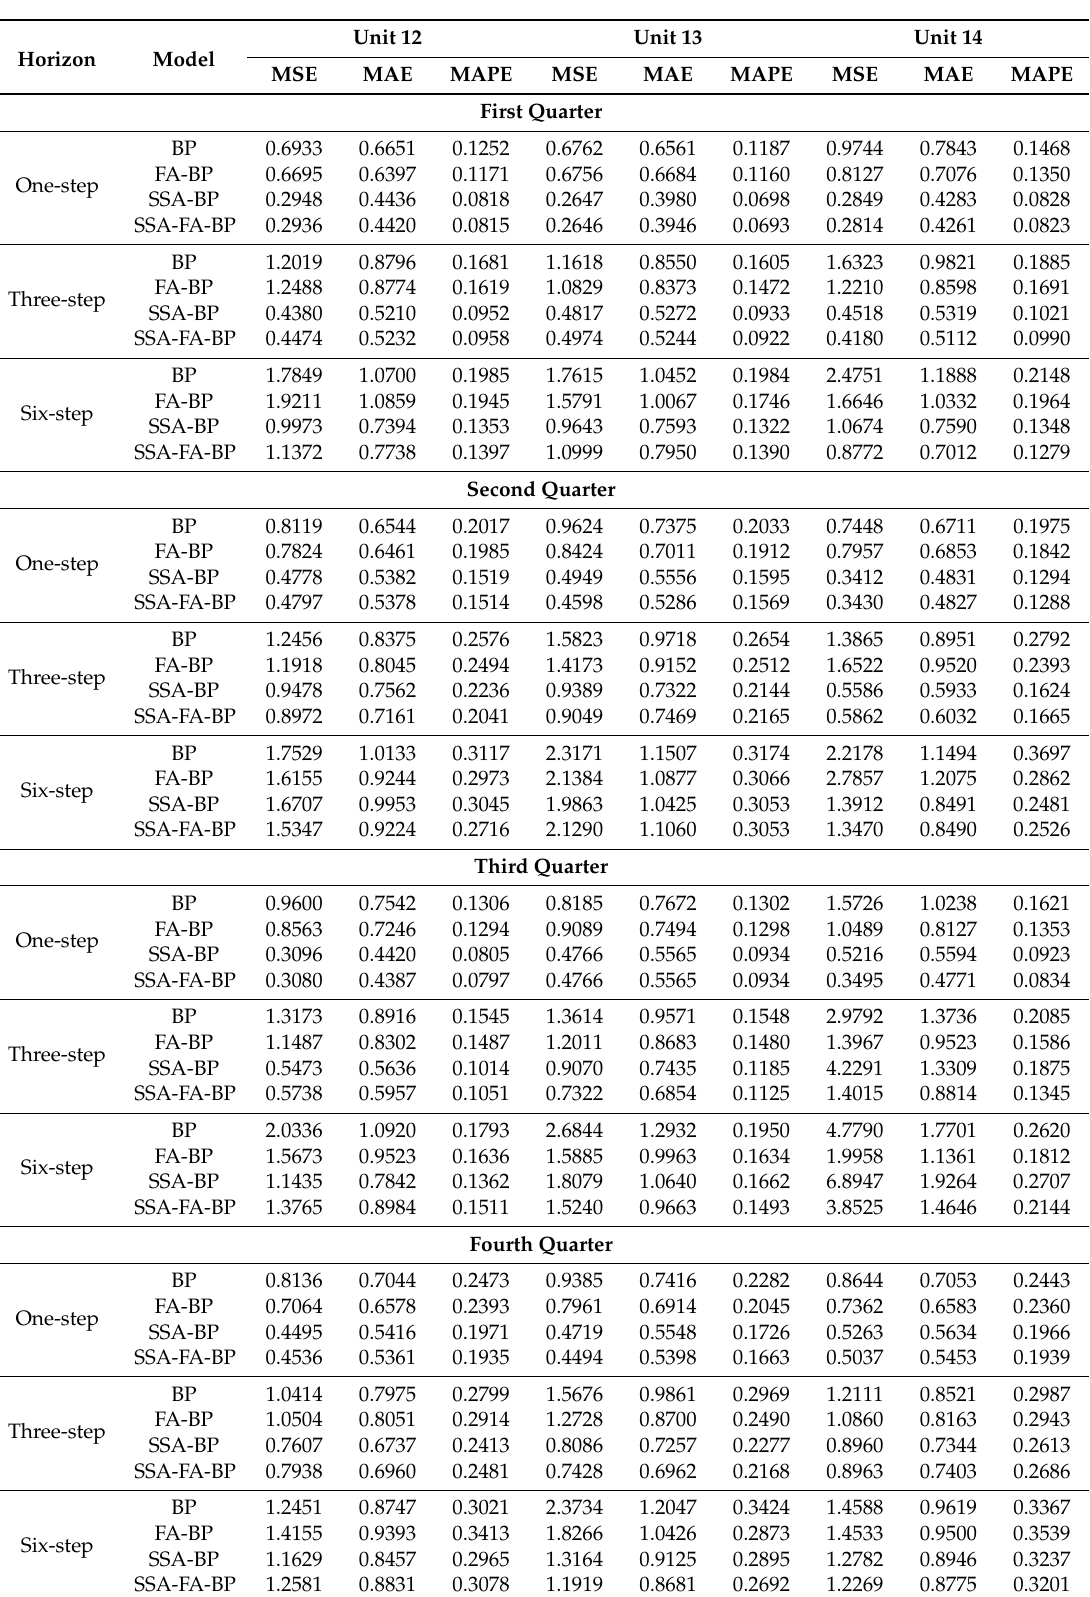
Table 6. The quarterly forecasting results of the combined model and the results of the other models involving the data of three Units (30